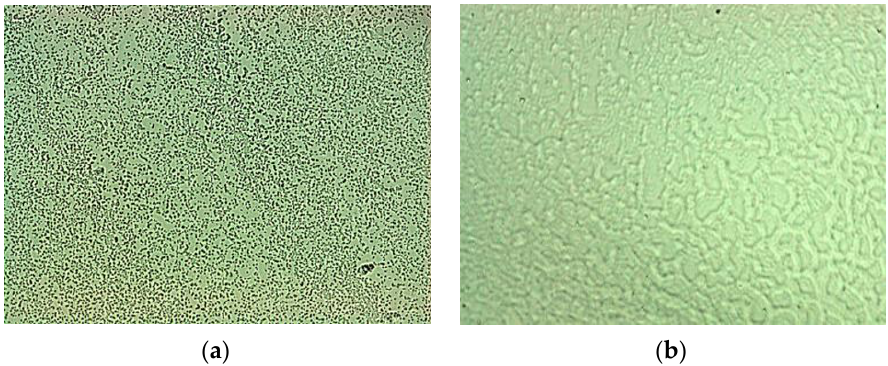
Figure 2. View of the solution-bacteria liquid: ( a ) after 1-day; ( b ) after 6-month. Biological microscope, 630×.